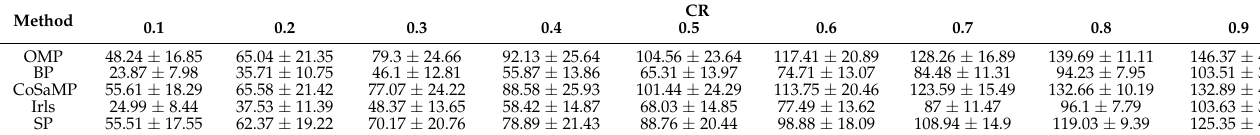
Table 2. PRD values of the reconstruction signals for the different compression ratios (CRs) based on the same wavelet basis. Values are means ± SD.